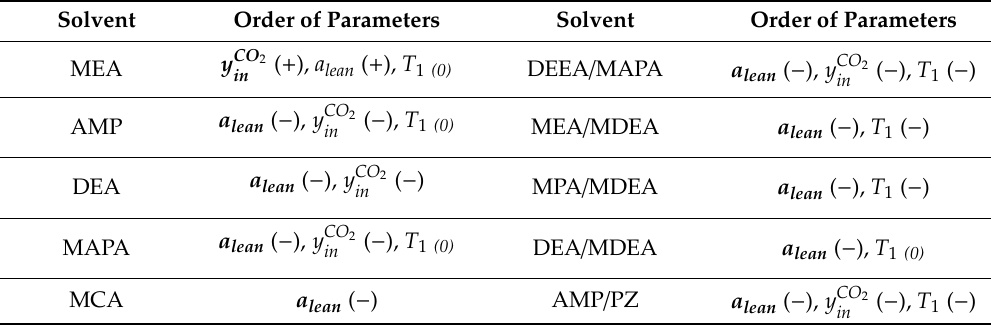
Table 7. Ranking of the parameters that a ff ected the performance indices of R lost , C sol , and ∆ α . Solvent Order of